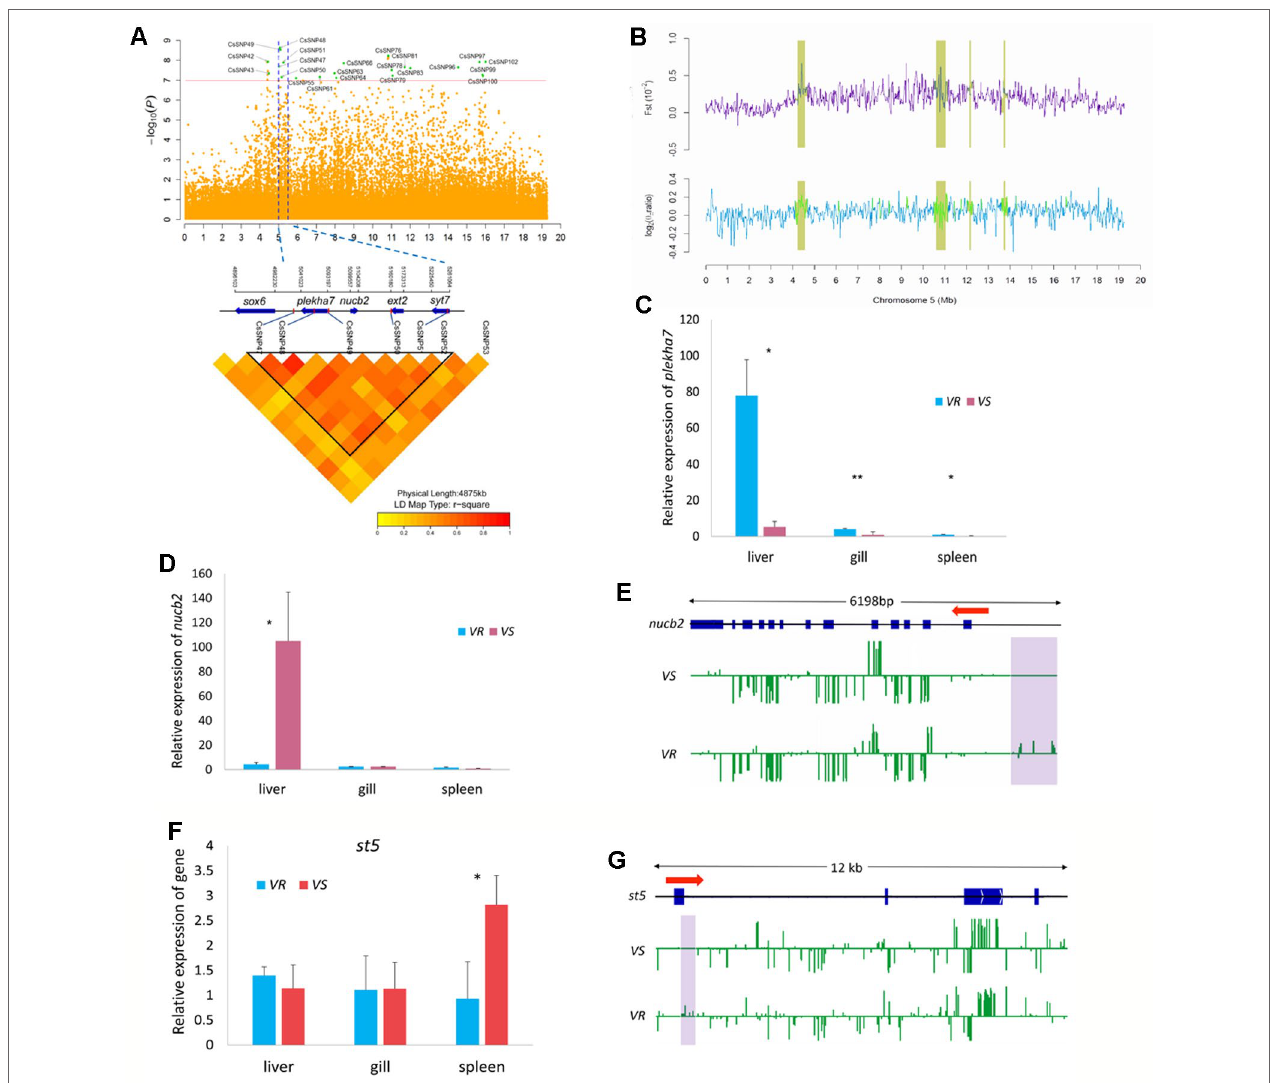
FiGURE 4 | Genome-wide association study (GWAS) and Fst and nucleotide diversity filtration identified plekha7 and nucb2 gene were related to the disease resistance on Chr 5. (A) Manhattan plot (top) and local linkage disequilibrium (LD) heat map (bottom). Blue dotted lines indicate the candidate region between 5.01 and 5.26 Mb. CsSNP48 and CsSNP49 were located within or near plekha7 and nucb2 gene. (B) The candidate regions (yellow shades) identified by Fs t and nucleotide diversity ( θπ ratio). (c , D , F) Relative messenger RNA (mRNA) expression of plekha7 (c) , nucb2 (D) , and st5 (E) gene in the V. harveyi -susceptible (VS) and V. harveyi -resistant (VR) families, detected by quantitative real-time PCR (qPCR). The average values of three samples in each group were used to represent the expression level. Asterisks indicate significance difference ( p < 0.05) and extremely difference ( p < 0.01), respectively. (E , G) Comparison of the methylation levels of nucb2 (E) and st5 (G) gene in the VS and VR families. The genomic sequence of the gene body, the upstream and downstream area was analyzed. The arrow indicates the direction of transcription. The blue boxes indicate the exons. The methylation level of cytosines is shown with green vertical lines and the violet shades indicate the significantly different methylation